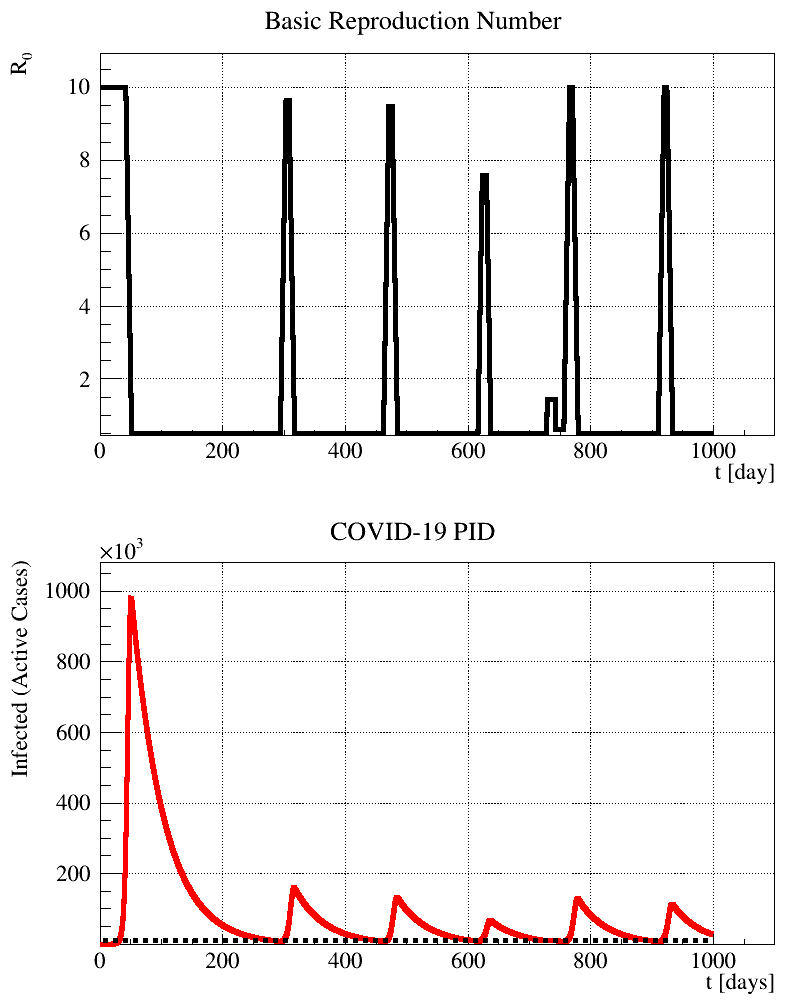
Figure 4. Example of PID controller simulation. Behaviour of ( top ) the input basic reproduction number, R 0 , and ( bottom ) the output number of the infectious individuals, I ( t ) , with K p = 10, K i = K d = 0. The dashed black line represents the set-point. A very strong proportional action only is not able to stabilize the system. This corresponds to the complete absence of restrictions at the beginning and a drastic lockdown when the threshold is reached, and this behaviour is repeated every time the set-point is reached, causing many out-of-control devastating epidemic